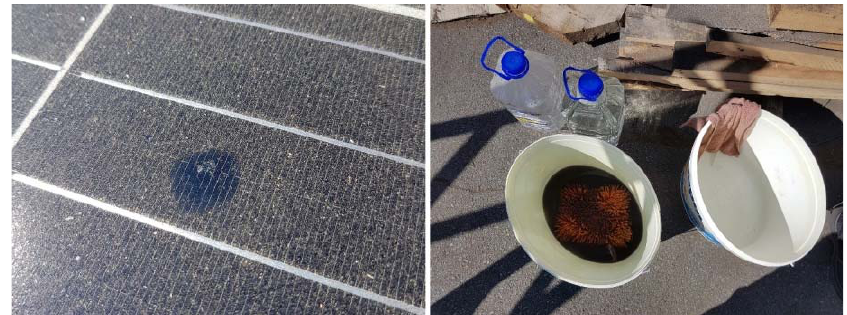
Figure 18. Dusted PV module appearance and washing equipment used for cleaning.